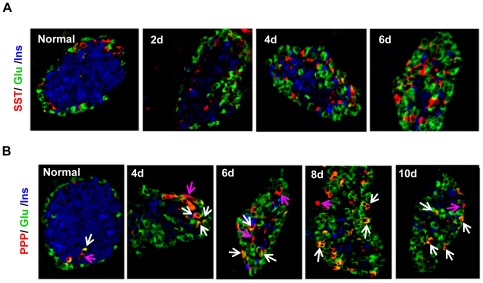
Islet architectural changes following STZ-mediated β-cell loss and non-β cell regeneration.
A: Distribution of α-, β- and δ-cells as assessed by triple staining with anti-insulin (blue), anti-glucagon (green) and anti-somatostatin (red) antibodies. The three cell types gradually lost their normal mantle-to-core zone organization, and became intermingled throughout the islets. B: Distribution of α-, β- and PP cells as assessed by anti-insulin (blue), anti-glucagon (green)) and anti-PPP (red) antibodies. Note: most regenerated PPP+ cells appeared to co-express glucagon (white arrows) following STZ treatment. This did not seem to be attributable to antibody cross-reaction because there were many individually stained α-cells and PP-cells (pink arrows).